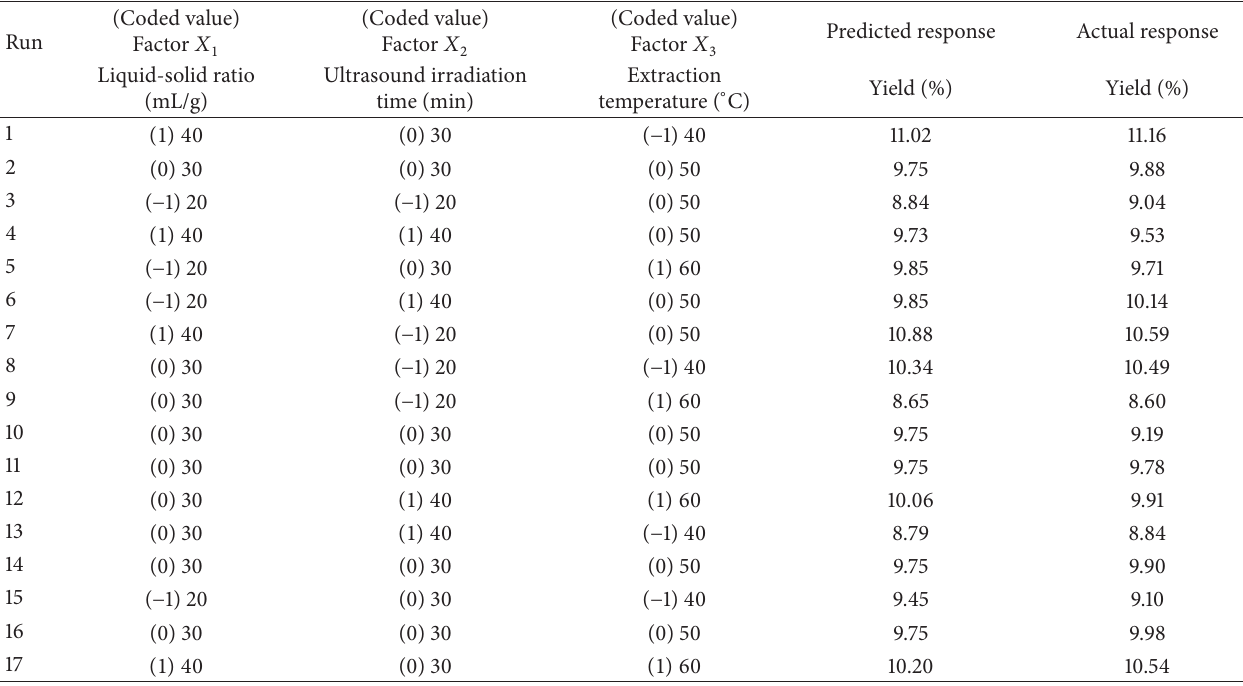
Table 1: The Box-Behnken design matrix to screen important variables, and the extraction yields of crude